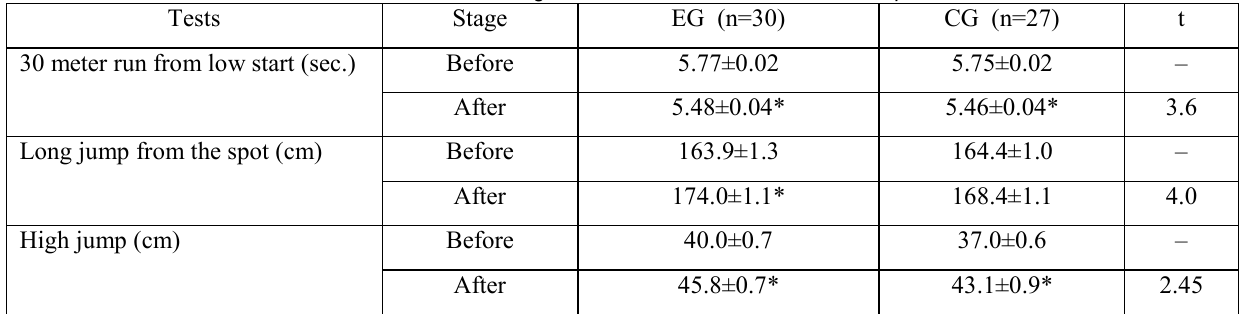
GPF indicators of junior karatekas before and after